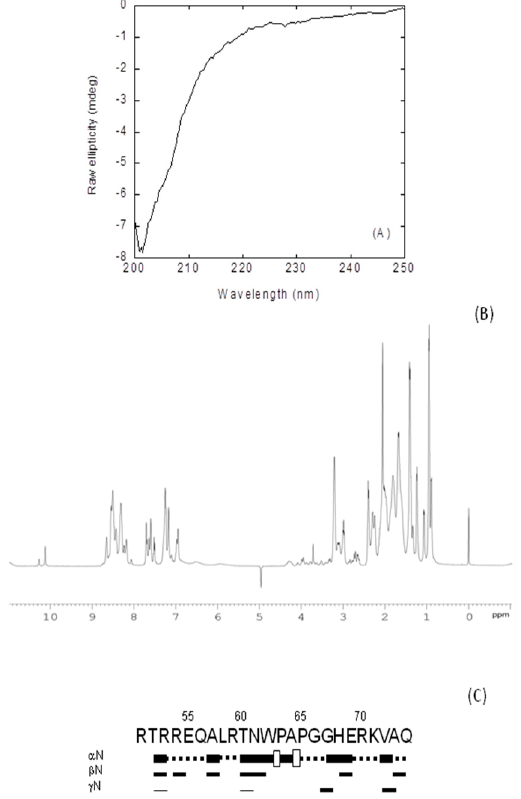
Figure 3. Conformational features of isolated nuclear localization sequence (NLS)-NUPR1L in solution: ( A ) Far-UV CD spectrum of NLS-NUPR1L at 298 K in phosphate bu ff er (50 mM, pH